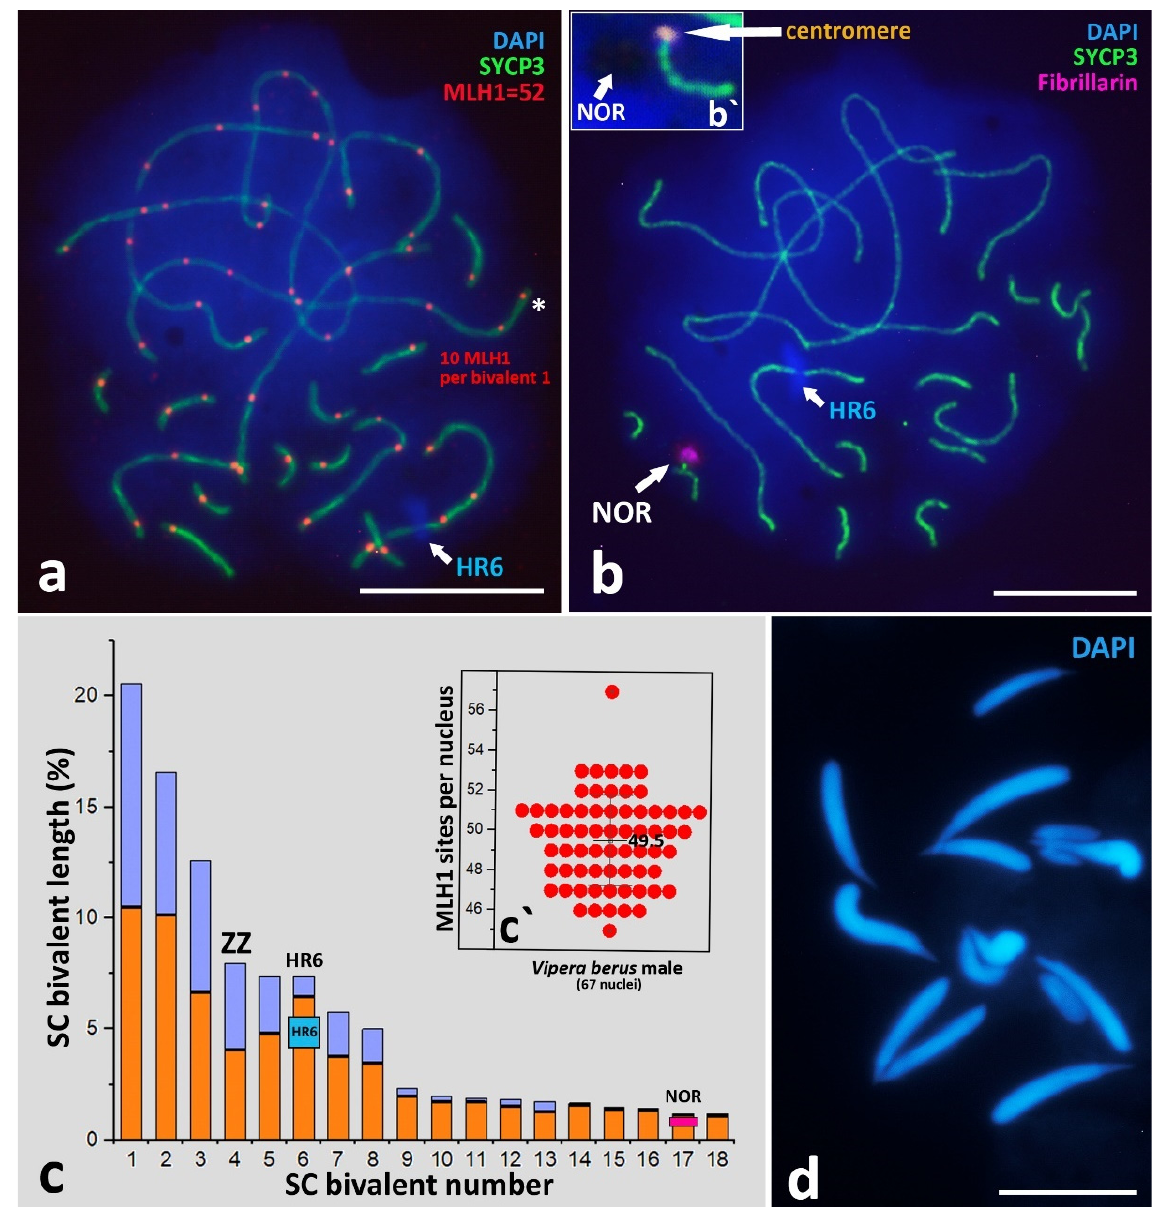
Figure 2. Markers of V. berus SC-karyotype, ideogram, and spermatids morphology. ( a ) Immunodetection of the crossing-over marker, MLH1 protein. A total of 52 MLH1 sites per nucleus, and 10 MLH1 sites on the bivalent 1 (asterisk). ( b ) Immunodetection of Nucleolar Organizer (NOR) on the microchromosome bivalent and (b`) as the DAPI-negative region. Axial elements of chromosomes are immunostained with antibodies against the SYCP3 protein (green); crossing-over sites are immunostained with antibodies against MLH1 protein (red); NOR with antibodies against Fibrillarin protein (violet). Chromatin stained with DAPI (blue). ( с ) Ideorgam of V. berus SC- karyotype. Blue—p arms; orange—q arms. Metacentric Z-chromosome, heterochromatin region (HR6), and NOR are indicated. Heterochromatin region on the chromosome pair 6 is indicated as HR6. ( c `) Number of MLH1 foci per spermatocyte nucleus (mean ± SD). ( d ) Spermatids, DAPI staining (blue). Bar—10 μ m.